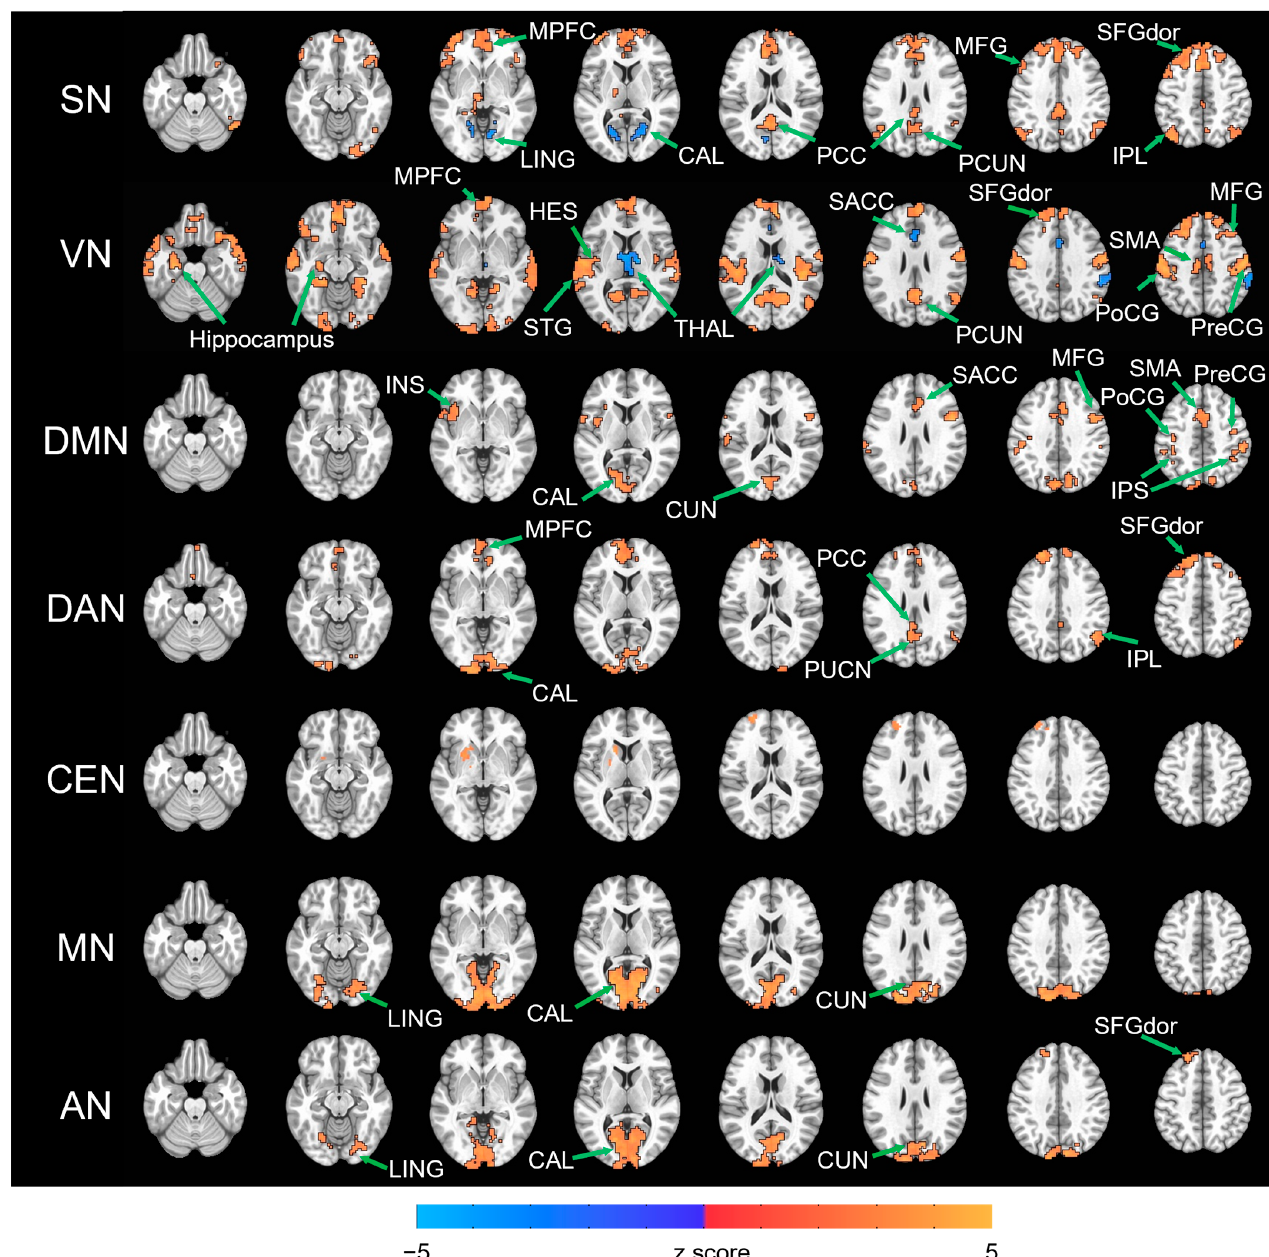
Figure 2. Paired t -test of FC difference (EC–EO) for each resting state network. All resulting statistical map were thresholded at voxel-wise p < 0.005 and cluster-wise alpha < 0.05. The regions, which showed significant difference and were identified to one of the seven networks, were marked with their names. For each network, eight slices are at z = − 23, − 13, − 3, 7, 17, 27, 37, 47, respectively.